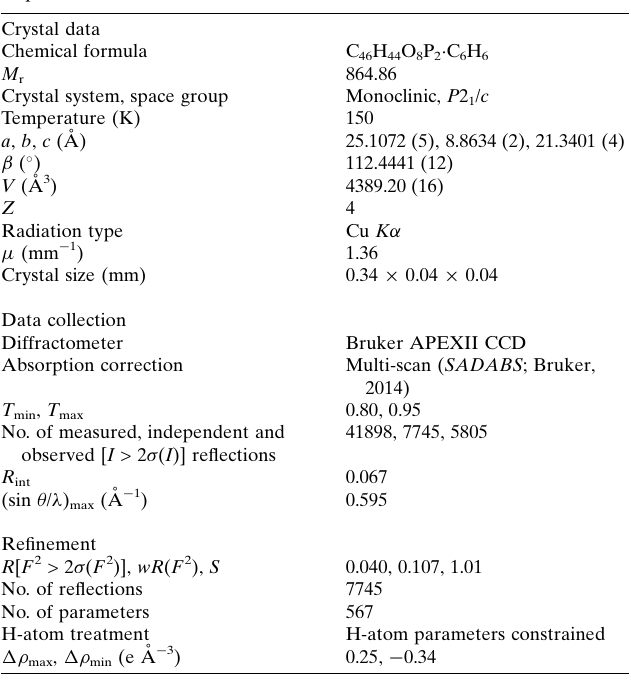
Table 2 Experimental details.